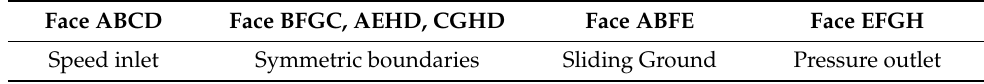
Figure 2. Train calculation domain. Table 1. The facets of the computational domain.